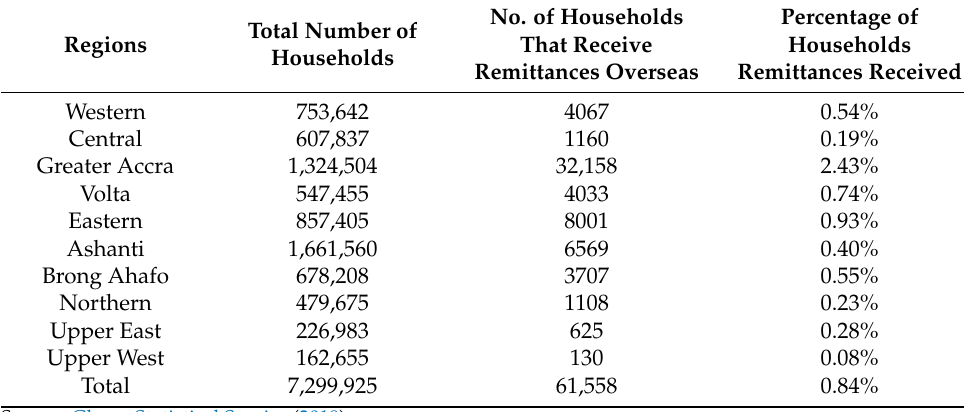
Table 3. Households remittances data in